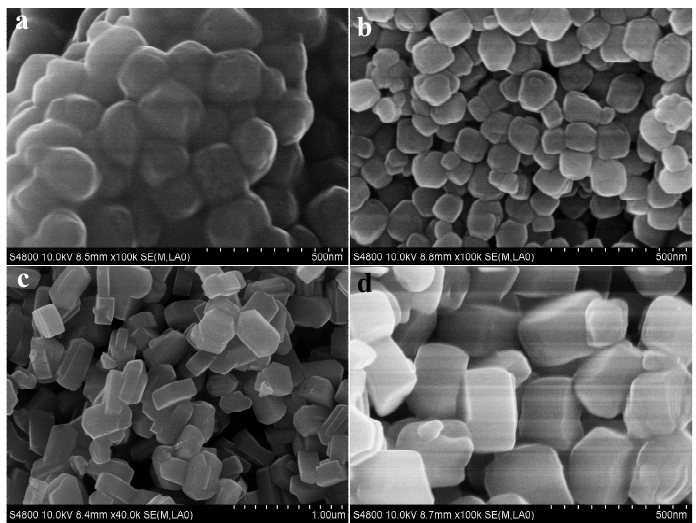
Figure 7. SEM images of silicalite-1 synthesized from silica spheres with various particle sizes of ( a ), 50 nm; ( b ), 100 nm; ( c ), 300 nm; ( d ), 500 nm.